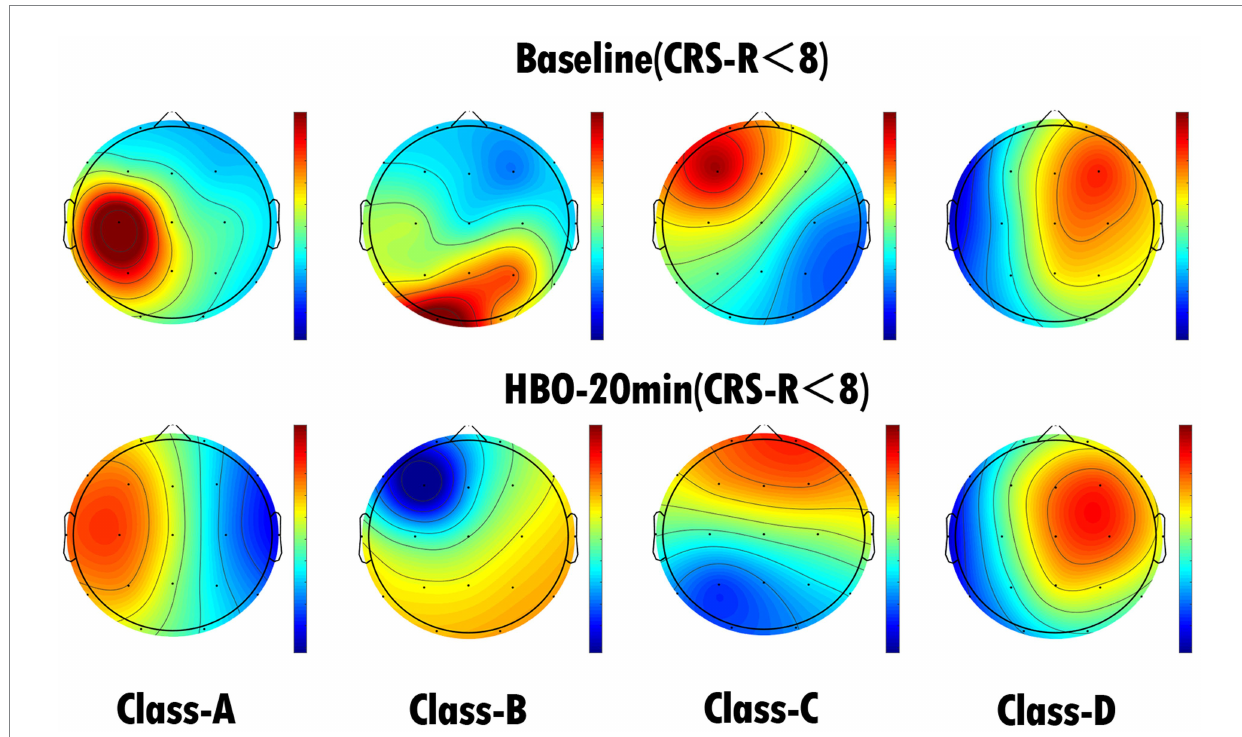
FIGURE 4 EEG microstate topography of DOC patients (24 cases) with CRS-R < 8. The top row is the EEG microstate topography map of the patients before HBO therapy, and the bottom row is the EEG microstate topography map of the patients after 20 min of HBO therapy.